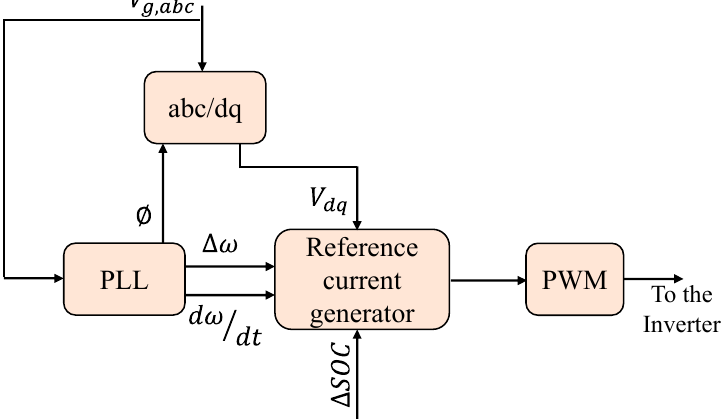
Figure 14. VSYNCH’s virtual-synchronous generator block diagram [6].